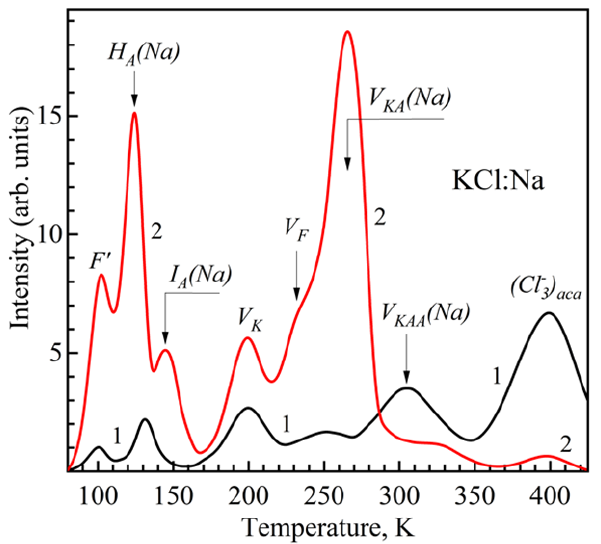
Figure 7. Spectrally integrated signal of TSL measured at a constant heating rate of β = 0.15 K/s for KCl:Na (1000 ppm) crystals exposed to isodose irradiation by X-rays at 85 K (3 h, 20 mA, 45 kV, W-anticathode). Curve 1 —a “decayed” crystal; curve 2— the sample additionally quenched at 600 o C.